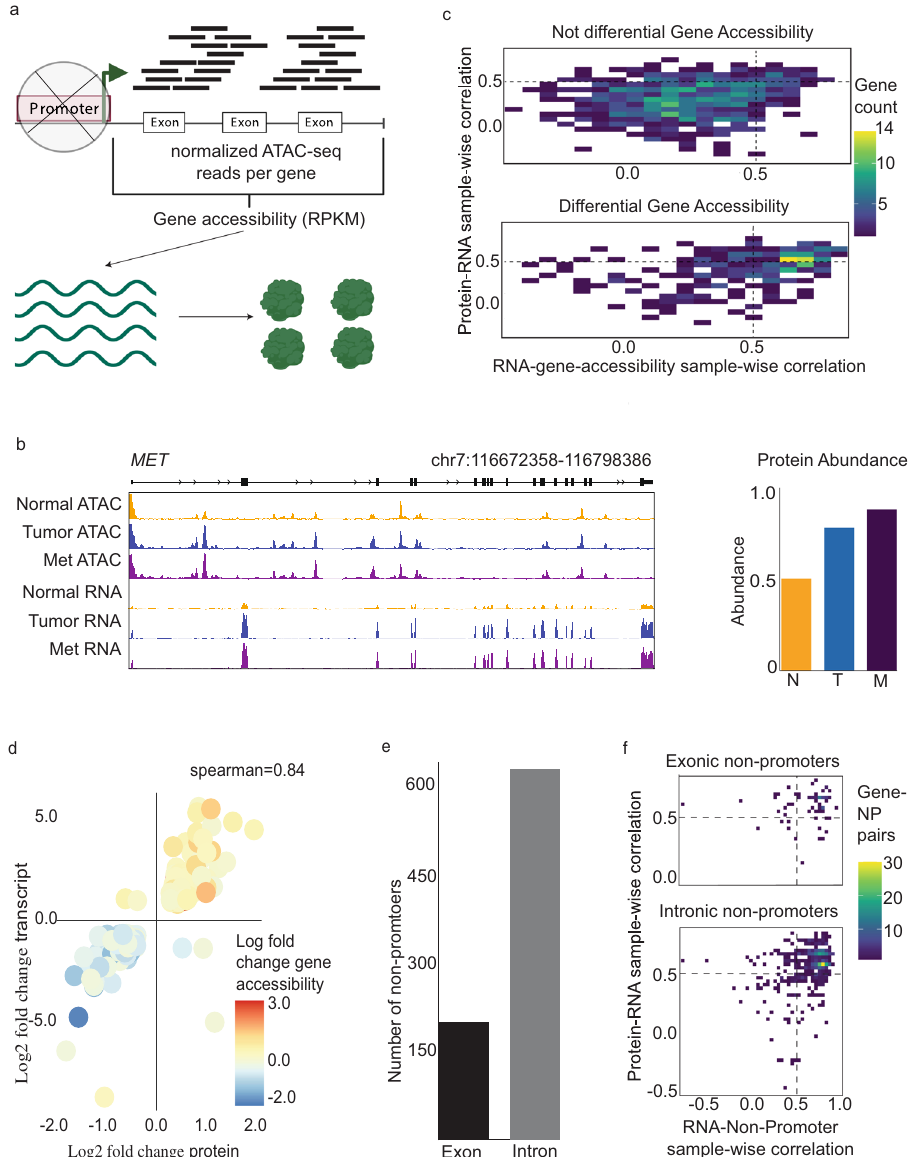
Fig. 3 Association of gene accessibility with RNA and protein abundances. a Schematic of the gene accessibility metric. b Visualization of gene accessibility and RNA and protein abundances for MET gene (top) and FN1 gene (bottom). Sample size; normal ATAC = 28, tumor ATAC = 30, met ATAC = 35, normal RNA = 27, tumor RNA = 30, met RNA = 30, normal protein = 21, tumor protein = 22, and met protein = 22. c Density of co- correlation between gene accessibility and gene expression. d Gene-wise correlation for genes with differential gene accessibility. e Frequency of exonic non-promoters and intronic non-promoters for differentially accessible genes (left) and distribution of the ratio of exonic length to intronic length for differentially accessible genes (right). f Comparison of exonic non-promoters (top) vs intronic non-promoters ’ sample-wise correlation